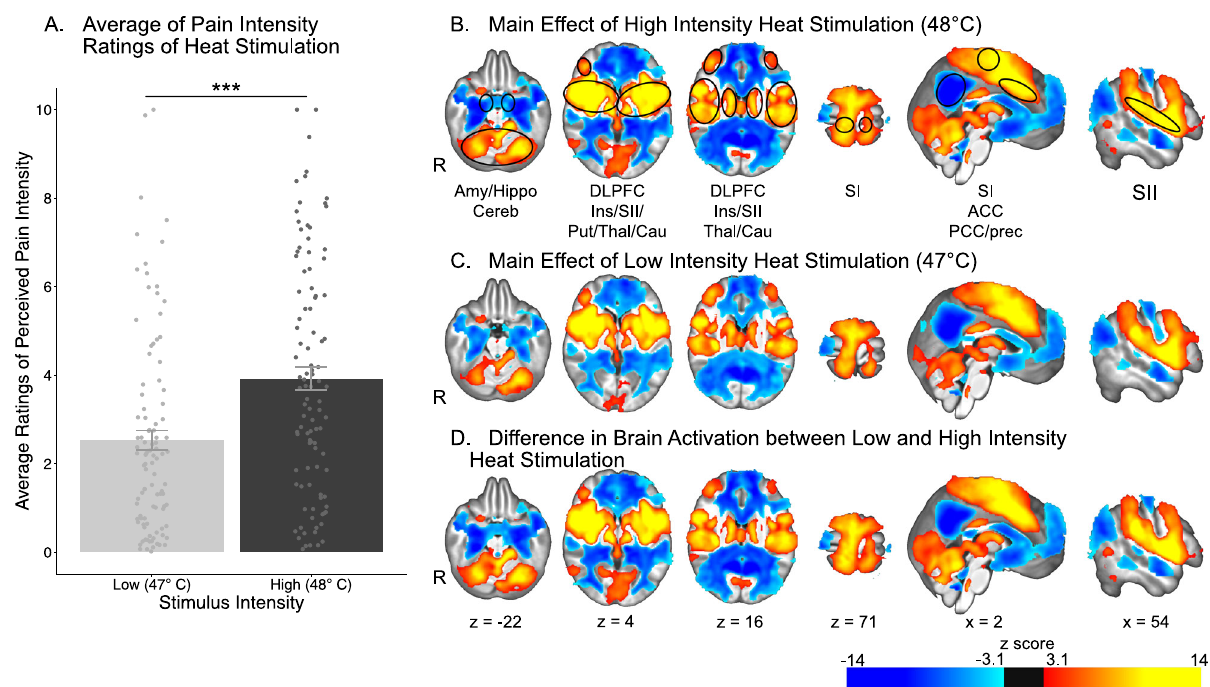
Fig. 5 Effect of graded increases in intensity of heat stimulation on brain activation. A Average ratings of pain intensity associated with heat stimulation signi fi cantly differed between high and low intensity stimulation, as shown by a two-sided paired sample t -test ( p = 2.2 e − 16 ). n = 101 participants. Increased brain activation in response to high ( B ) and low ( C ) intensity heat stimulation and differences between the two intensities of stimuli ( D ) are observed in areas such as the putamen (Put), the caudate nucleus (Cau), the thalamus (Thal), the primary somatosensory cortex (SI), the secondary somatosensory cortex (SII), the insula (Ins), dorsolateral prefrontal cortex (DLPFC), and the anterior cingulate cortex (ACC). Decreased activation in response to the same stimuli is especially present in the precuneous (Prec) and the posterior cingulate cortex (PCC). Error bars represent standard error of the mean. *** represents p values < 0.001. Source data are provided as an xlsx Source Data fi le and activation maps are available on Github.